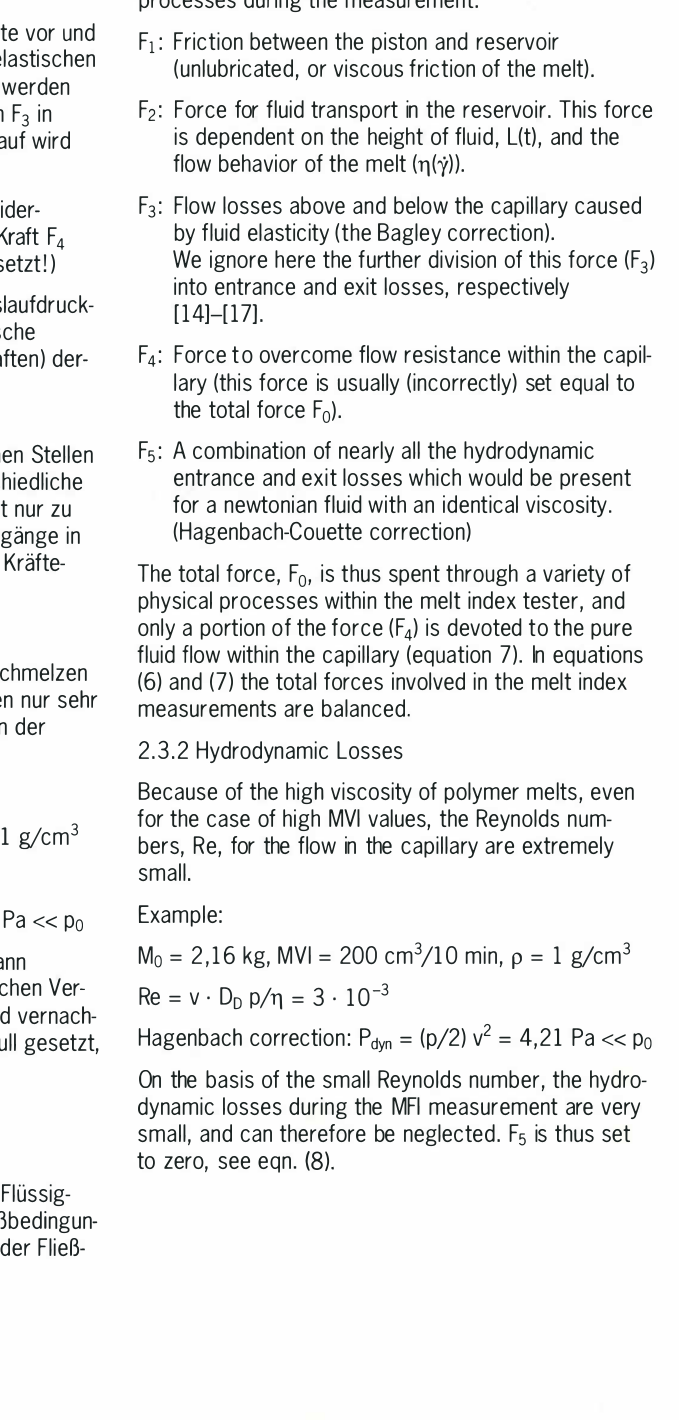
Schmelzindexpriifgeriites Fo= GesamtkrafVtotal force und Zusammenfassung der F 1 = Reibkraft zwischen Kolben wesentlichen Kriifte F; und Zylinderwand/ friction between the piston and reservoir Fig. 2: F 2 = Viskoser Verlust im Priifzylinder Sketch of the melt index viscous losses in the tester and summary of the test cylinder important forces F; F 3 = Oruckverlust aus den elastischen Fliissigkertseigenschaften flow losses caused by fluid elasticrty F 4 = Viskoser Druckvertust in der Oiise/viscous pressure loss in the capillary F 5 = Hydrodynamische